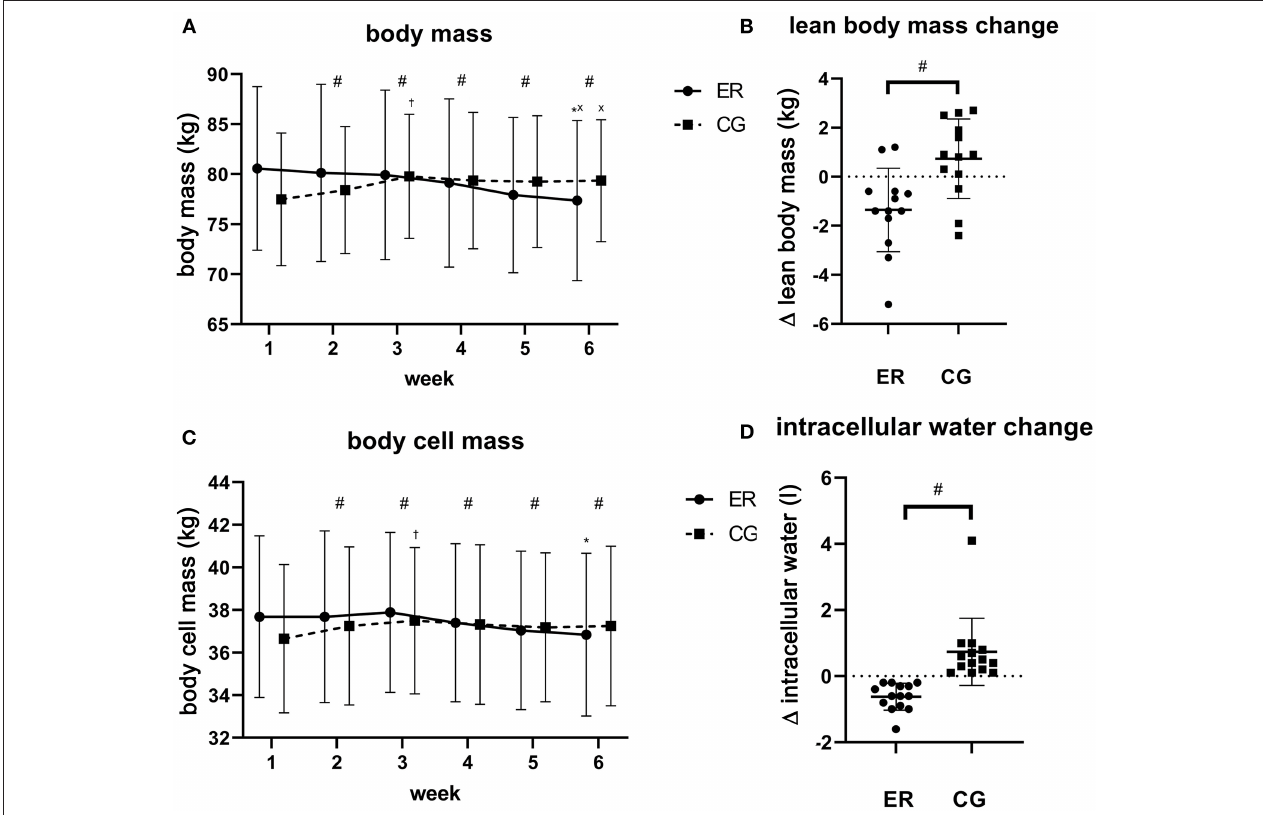
FIGURE 3 | Visual representation of measured parameters. The figure shows body mass change (kg) (A) , 1 lean body mass (week 6–1; kg) (B) , body cell mass change (kg) (C) as well as 1 intracellular water (week 6–1; l) (D) . Data is plotted as means ± standard deviation. # Illustrates a significant difference between groups (